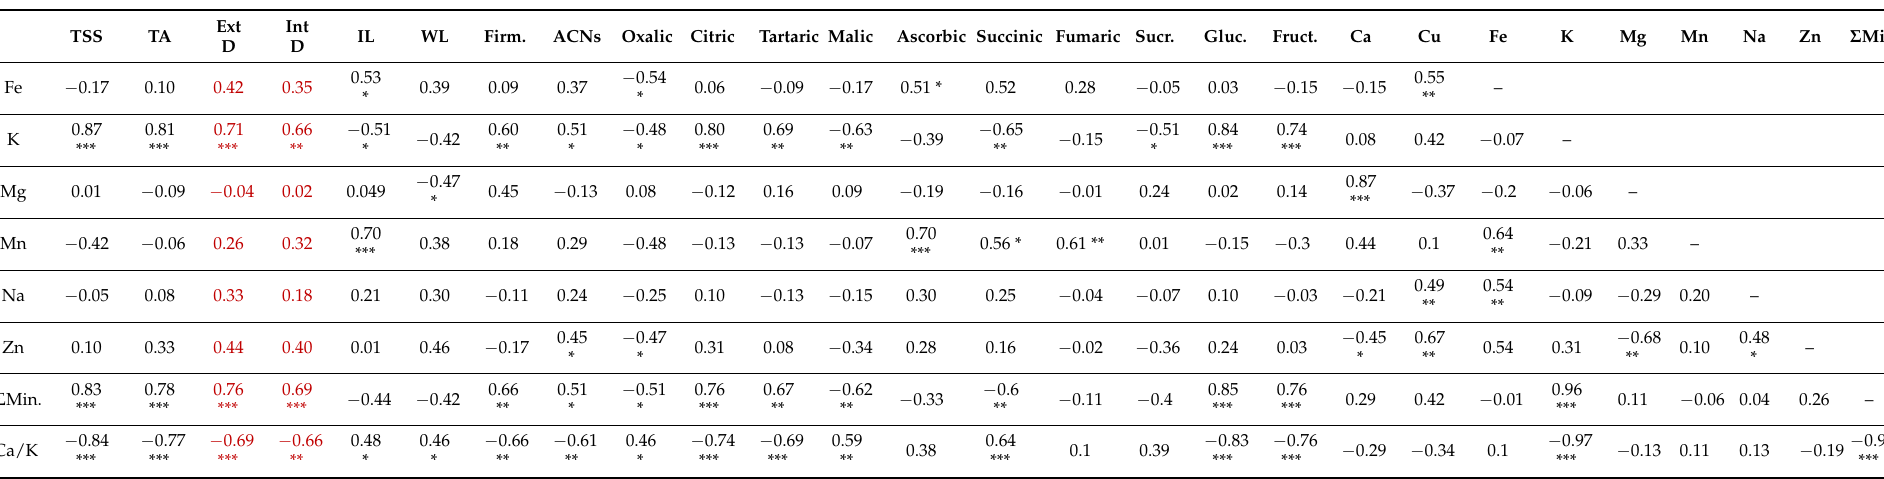
Red letters show the correlation between external and internal CI indexes and dependent variables. TSS: Total Soluble Solids, TA: Titratable Acidity, Ext D or Int D: external or internal peel CI index, IL: Ion Leakage, WL: Weight Loss, ACNs: Anthocyanins, Firm.: Firmness, Sucr.: Sucrose, Gluc.: Glucose, Fruct.: Frutose, Σ Min.: Mineral Sum. *** Significant difference at p < 0.001. ** Significant difference at p < 0.01. * Significant difference at p <